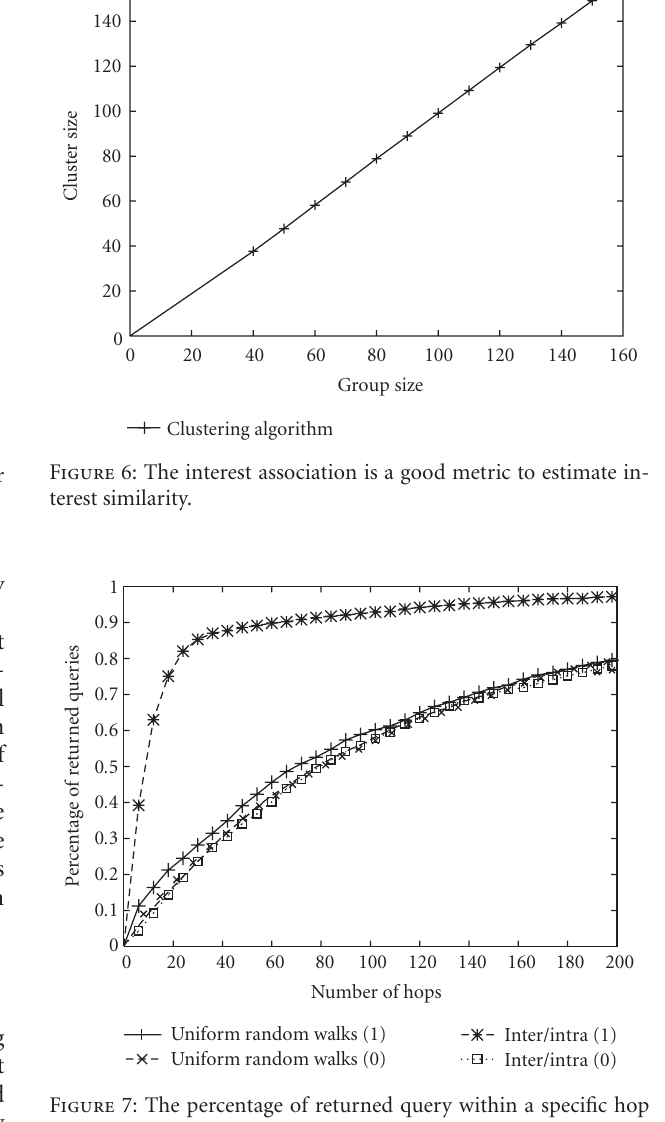
Figure 7: The percentage of returned query within a specific hop